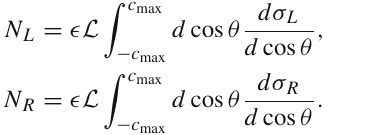
cross-sections. Here, we set COM energy of the ILC at with 1 ab − 1 (left) and 5 ab − 1 (right) integrated luminosity. Here the horizontal solid black lines correspond to the 1 σ and 2 σ ( 2 σ and 3 σ ) sensitivity for left (right) figure, and the grey shaded region corresponds to excluded region from the SM Z boson mass